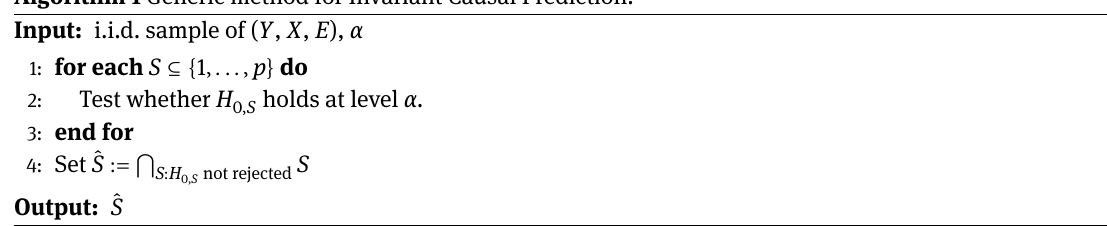
Algorithm 1 Generic method for Invariant Causal